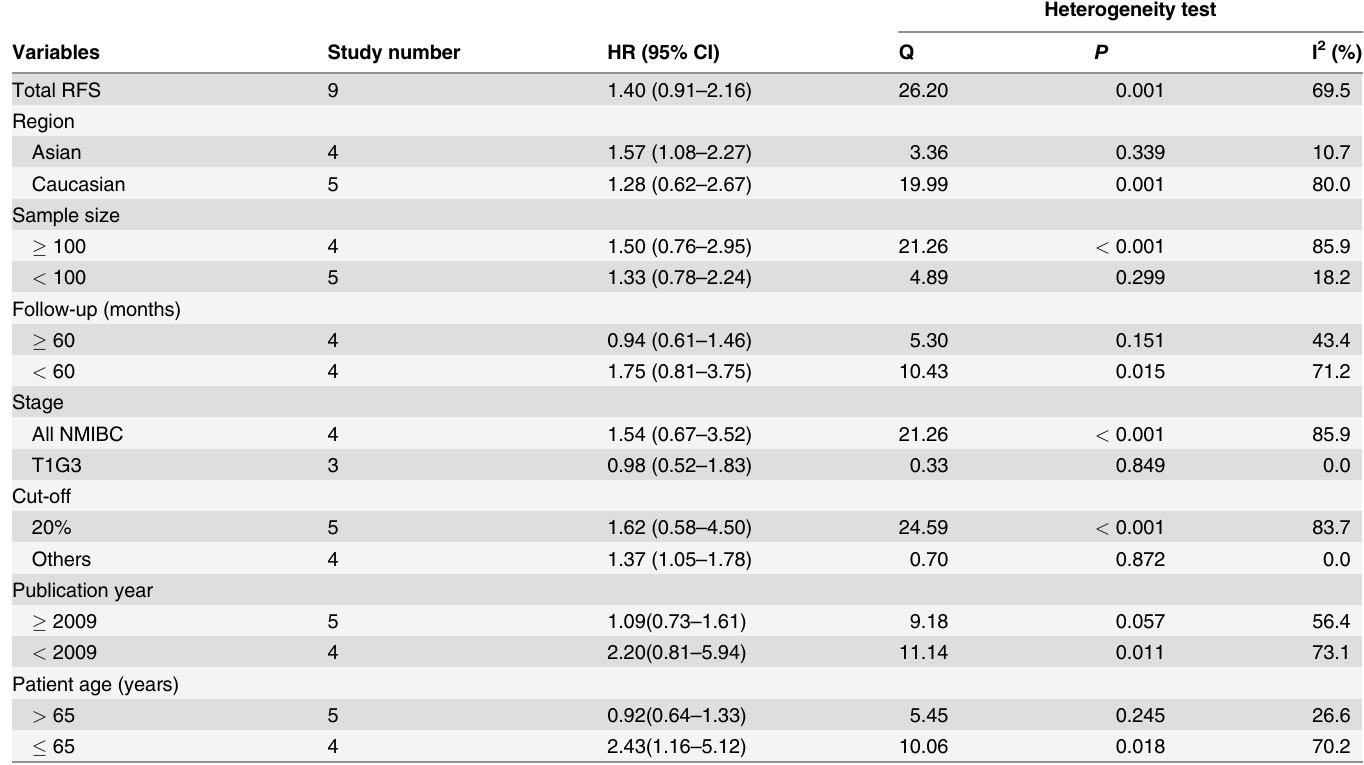
Table 2. Subgroup results of RFS and heterogeneity